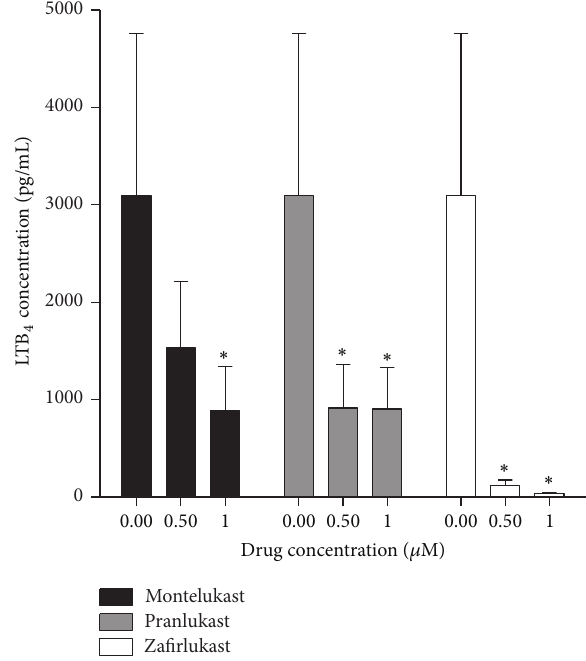
Figure 4: Effects of montelukast, pranlukast, and zafirlukast (0.5 and 1 𝜇 M) on the production of LTB 4 by PAF-activated neutrophils. The results are presented as the mean values for total extracellular LTB 4 (pg/mL) and vertical lines show SEM ( 𝑛 = 9 with 2 replicates foreachdrugconcentrationandcontrolsystemineachexperiment). The absolute values for the unstimulated control system and for cells activated were 21 ± 5 and 3092 ± 1669 pg LTB 4 /mL, respectively. ∗ 𝑃 < 0.05 for comparison with the drug-free control